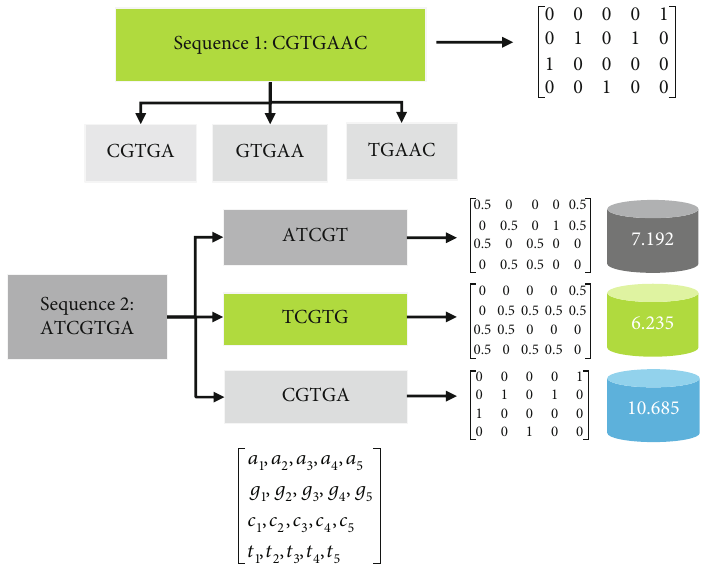
Figure 5: Displayed results of two gene sequence